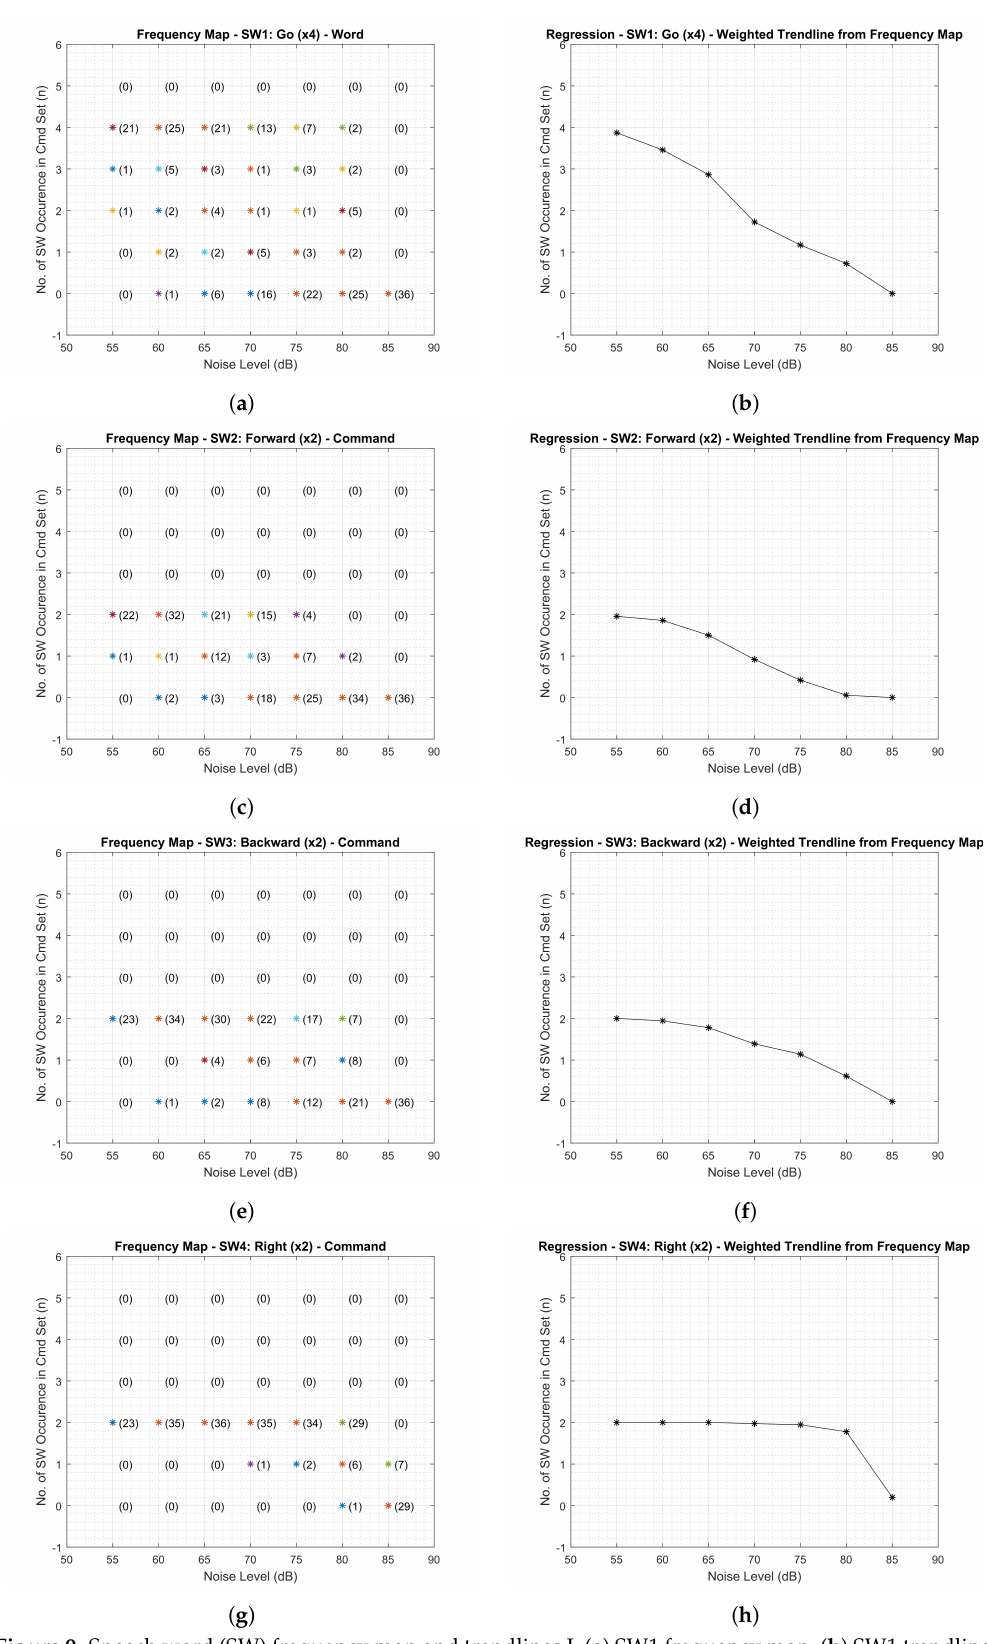
Figure 9. Speech word (SW) frequency map and trendlines I. ( a ) SW1 frequency map, ( b ) SW1 trendline, ( c ) SW2 frequency map, ( d ) SW2 trendline, ( e ) SW3 frequency map, ( f ) SW3 trendline, ( g ) SW4 frequency map, ( h ) SW4